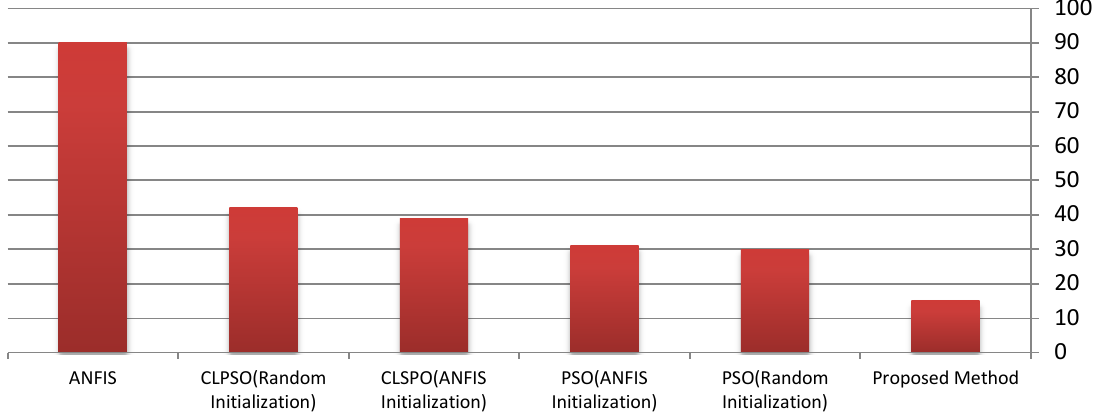
Figure 8. The number of fuzzy rules of the existing